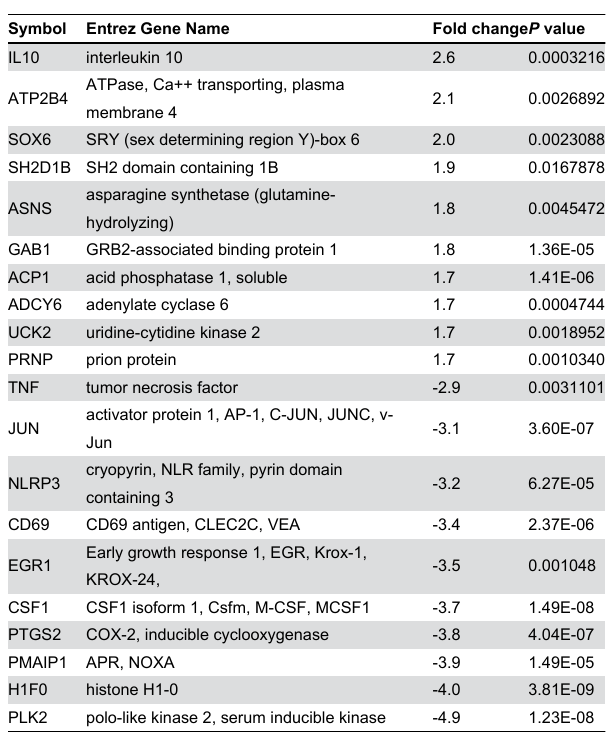
Table 6. Bone marrow adipocyte genes most highly up- and down-regulated by a high fat diet at 14 months of age.